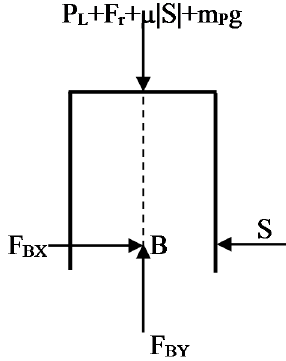
Figure 4. The modelled forces on the piston.